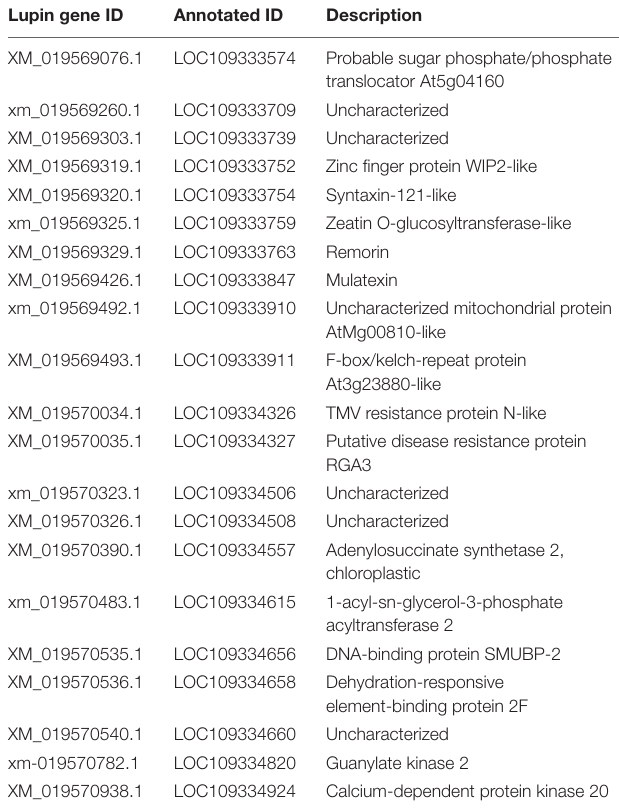
TABLE 2 | List of annotated genes in the fine-mapping